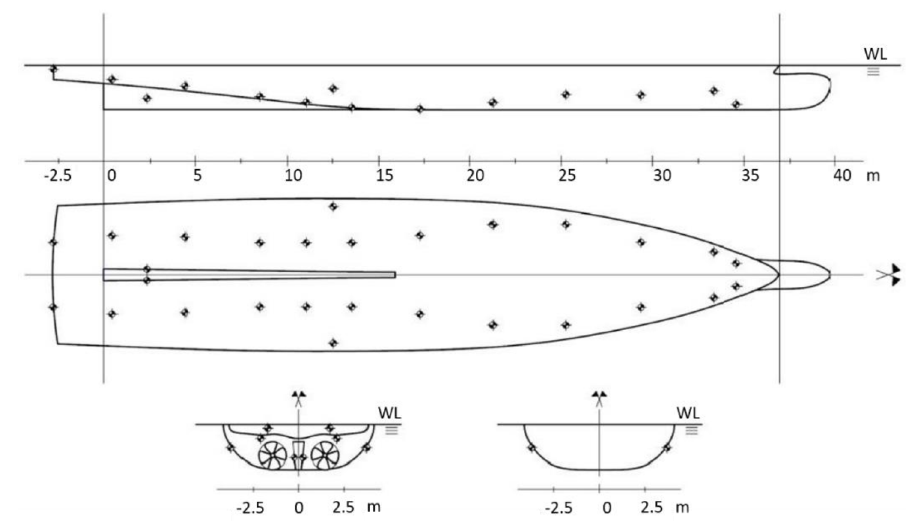
Figure 3. Positioning of galvanic anodes onboard the superyacht.